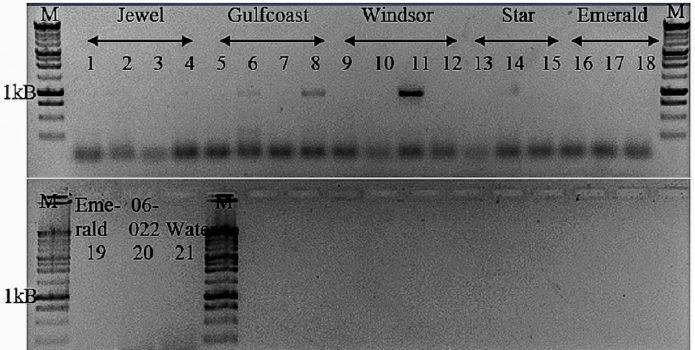
Figure 5. Validation of the putative new tepovirus in extracted RNA of different V. corymbosum cultivars from Island Grove by PCR, producing expected amplicons at ~1 kB. Cultivar’s name was shown at the top of the gel. M, 1 kB DNA ladder.